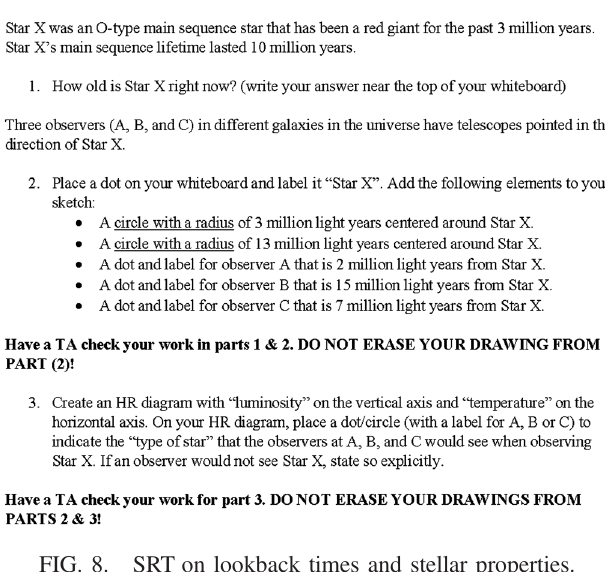
FIG. 8. SRT on lookback times and stellar